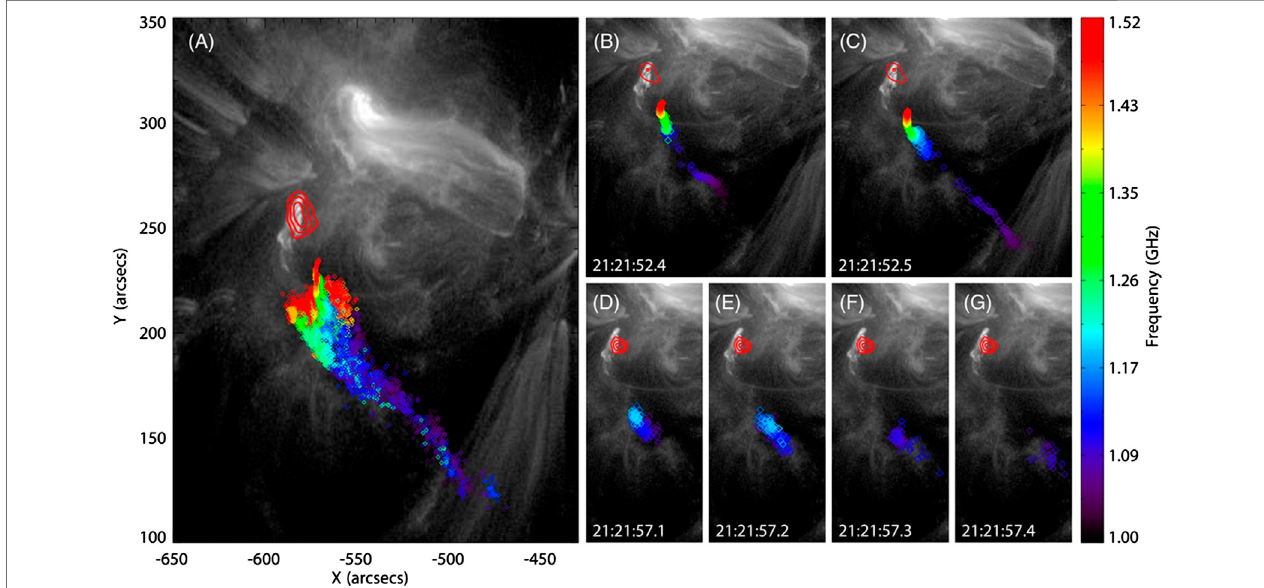
FIGURE 2 | Spectral imaging maps of a group of decimetric type III bursts (panel (A) ) and an individual burst (B) – (G) with the VLA on November 5, 2011 . The centroid positions of the radio source are coded in colors depending on the frequency as shown in the colorbar on the right, and overlaid on an SDO/AIA image at 13.1 nmwavelength.Theredcontoursin (A) showthehardX-raysourcemappedinthe12 – 25 keVrangebyRHESSI.FromChenetal.(2013).©AAS.Reproducedwith permission.